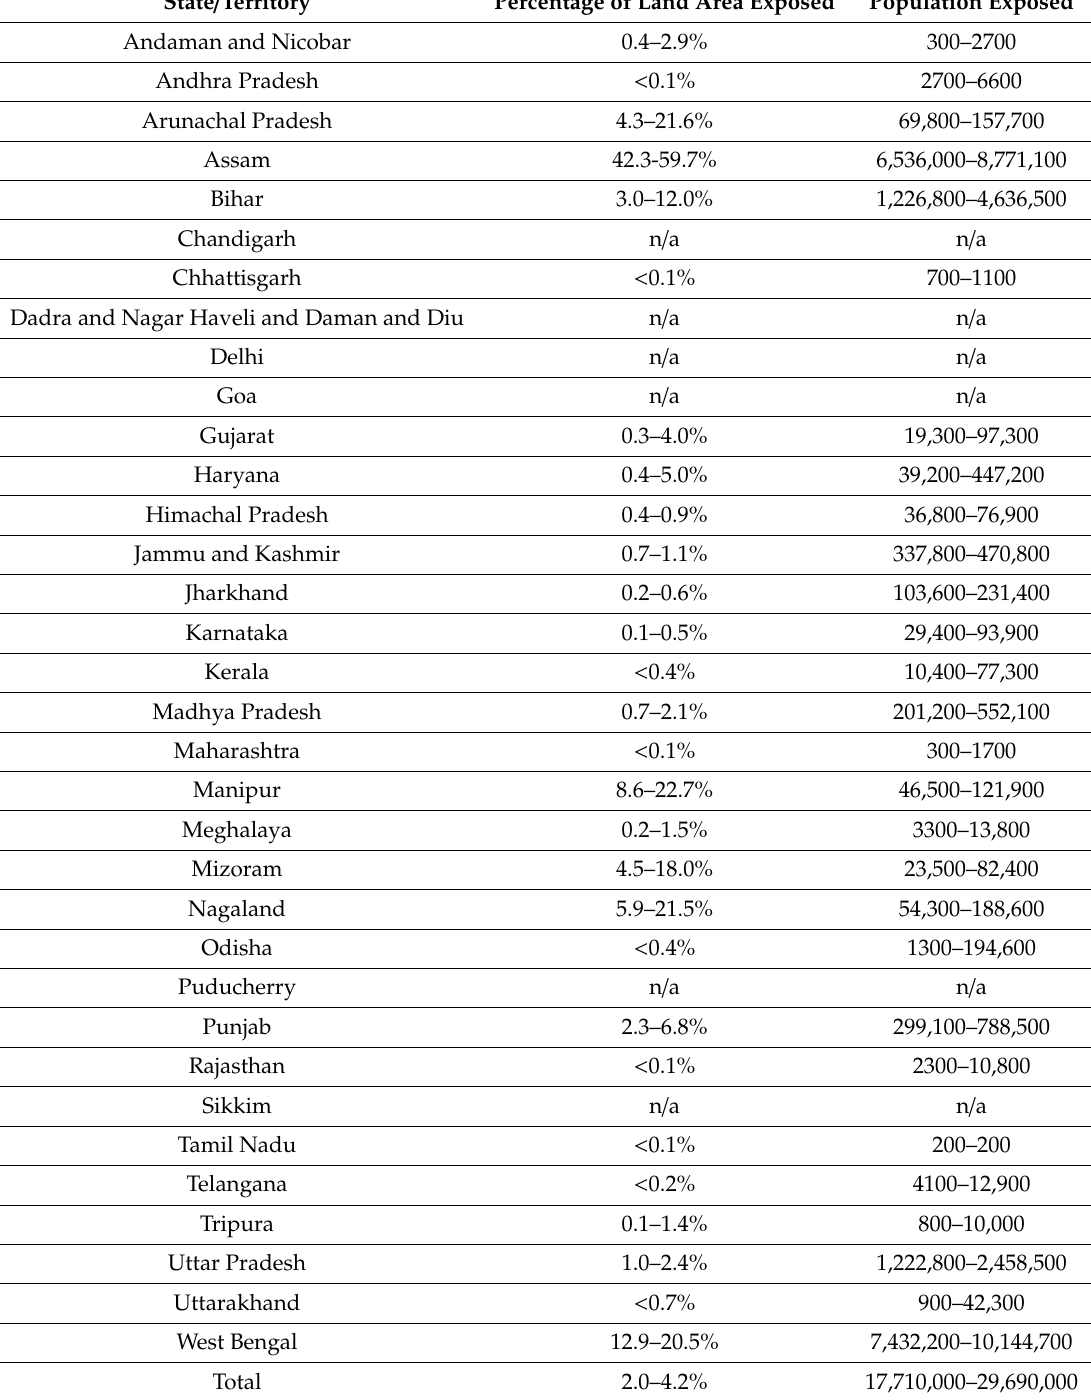
Table 4. Area and population potentially exposed to arsenic concentrations greater than 10 µ g / L by state / territory. Based on probabilities in Figure 2a exceeding 0.49 and 0.55 along with the rates [64] of household groundwater use in rural and urban areas. See text for